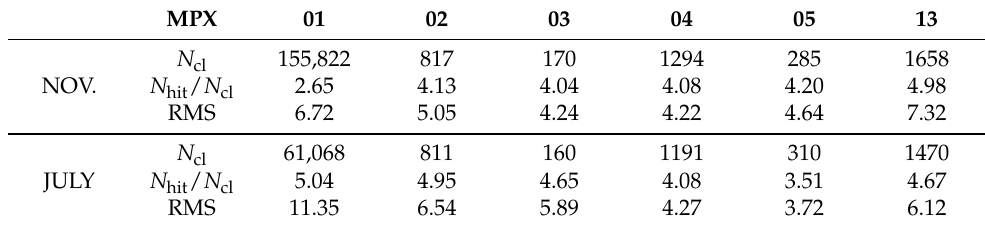
Figure 8. Number of hits per cluster, combined for six cluster types. Data are taken by MPX01 and MPX13 during the last horizontal van der Meer (vdM) scan of November 2012 (LHC fill 3316). Taken from Ref. [11]. Table 5. Number of clusters, N cl , average ratio of hits per cluster, N hit / N cl , and root mean square (RMS) values of the hits per cluster distributions, shown in Figure 8. Data are taken by MPX01-05 and MPX13 during the last horizontal van der Meer (vdM) scan of November 2012 (LHC fill 3316). For comparison, the corresponding values are given for one of the vertical vdM scans of July 2012 (LHC fill 2855). In this study, no noisy pixels are removed for the hit counting or cluster counting, and the smaller ratio in November for MPX01 can be explained by the increase in the number of noisy pixels during the year. Taken from Ref.